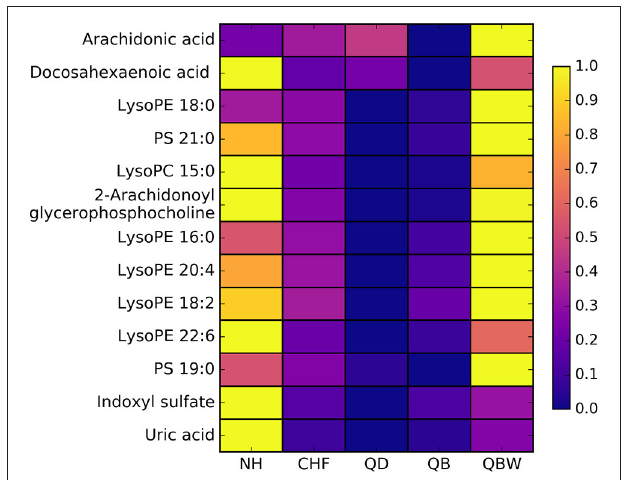
FIGURE 7 | Heat map of differential metabolites. NH, Normal healthy group; QD, Qi deficiency group; QB, Qi deficiency and Blood stasis group; QBW, Qi deficiency and Blood stasis and Water retention